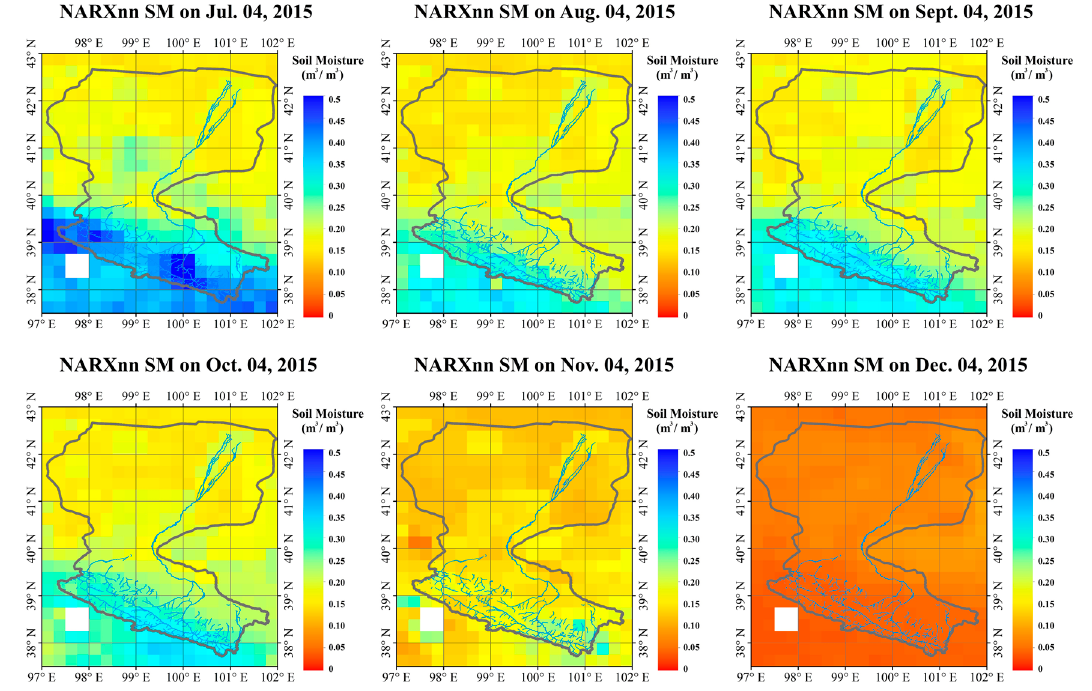
Figure 8. Maps of the spatial distribution of NARXnn SM covering the HRB on the 4th day of each month in 2015.